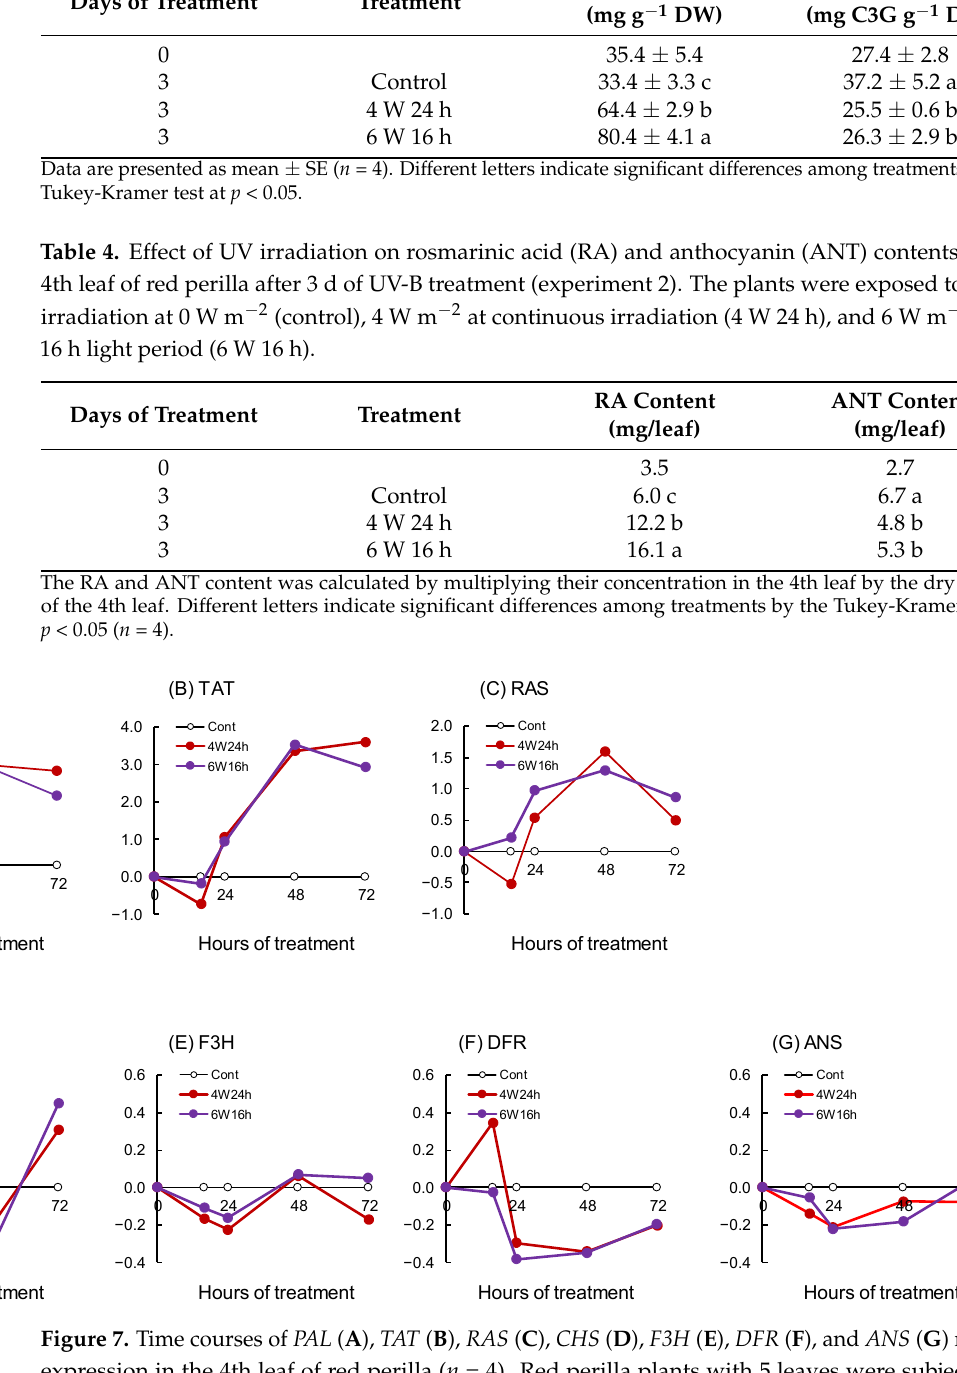
Table 3. Effect of UV irradiation on rosmarinic acid (RA) and anthocyanin (ANT) concentrations in the 4th leaf of red perilla after 3 d of UV-B treatment (experiment 2). The plants were exposed to UV-B irradiation at 0 W m − 2 (control), 4 W m − 2 at continuous irradiation (4 W 24 h), and 6 W m − 2 for a 16 h light period (6 W 16 h). Days of Treatment Treatment